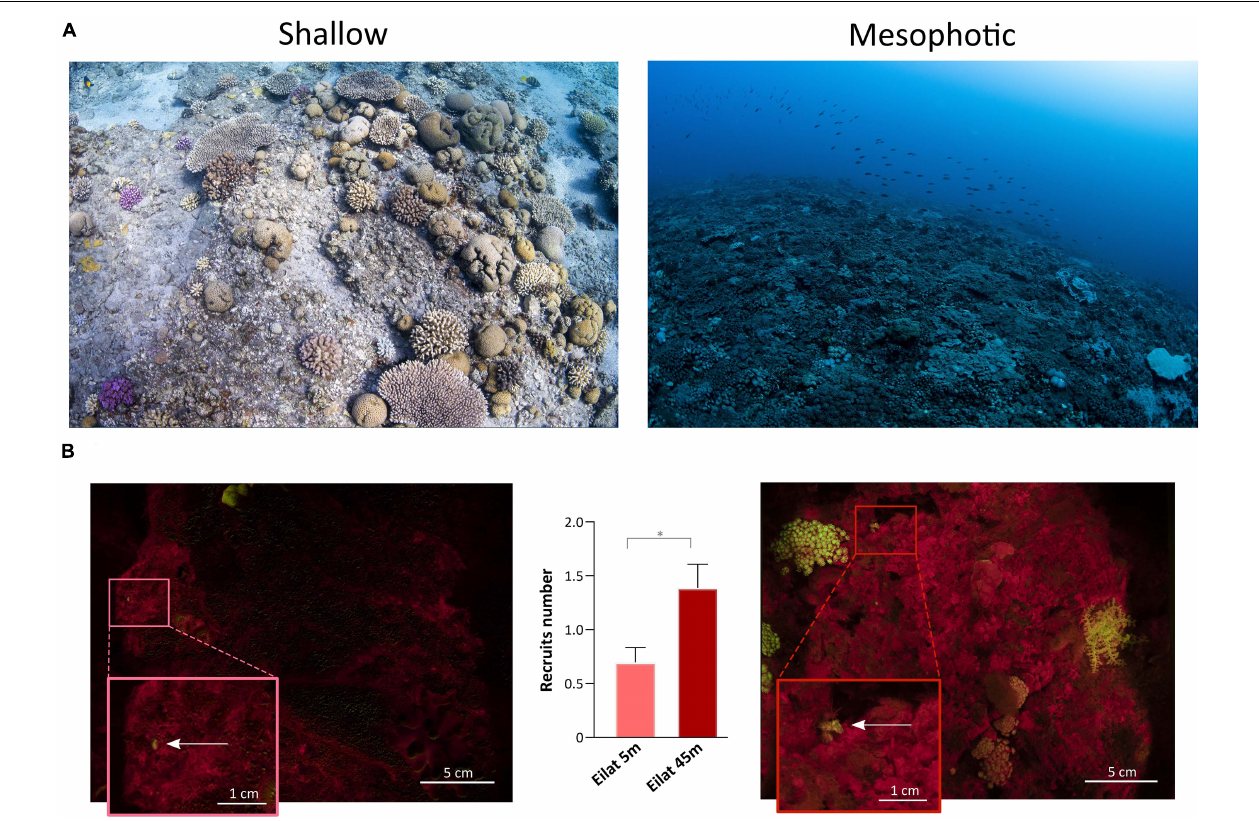
FIGURE 6 | Shallow and mesophotic reefs in Eilat and detection of coral recruits. (A) Images of the sampling sites at the shallow (left) and mesophotic (right) reefs in Eilat. (B) Fluorescence images of the quadrat deployed in the shallow (left) and mesophotic (right) reefs of Eilat. The arrows within the insets point to coral recruits. The central graph shows the number of recruits identified in the shallow ( n = 46 quadrats) and mesophotic ( n = 36 quadrats) reefs of Eilat. Values are shown as means ± SEM. Asterisk indicates statistical difference (Mann-Whitney test, P < 0.05).